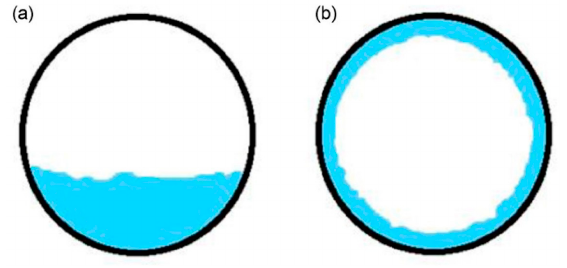
Figure 13. Fluid flow in ( a ) horizontal vs. ( b ) vertical heat exchangers [47].